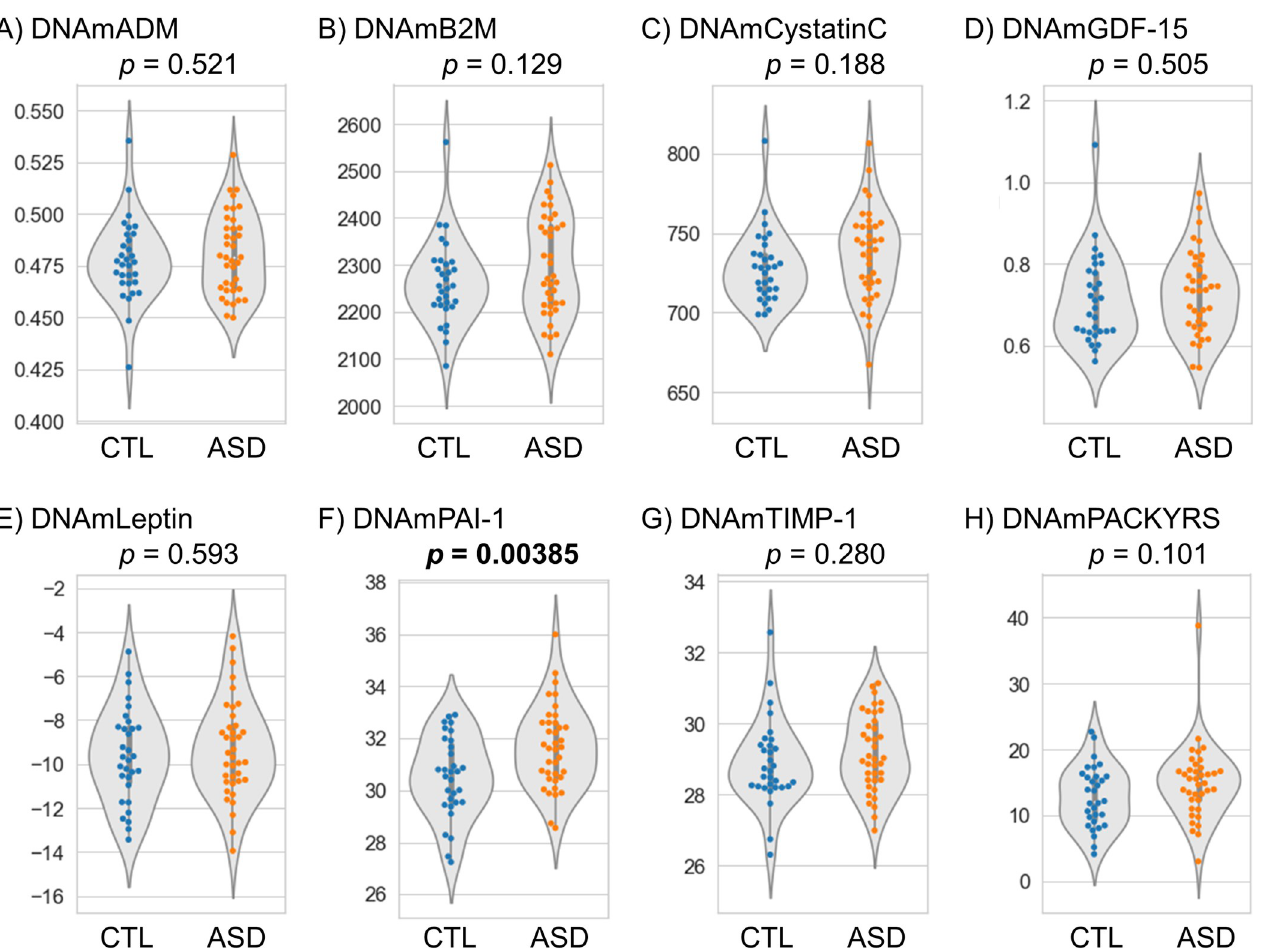
Fig 2. DNA methylation-based age-related plasma proteins and smoking status in the 1st cohort. ( A ) ADM, ( B ) B2M, ( C ) Cystatin C, ( D ) GDF-15, ( E ) Leptin, ( F ) PAI-1, ( G ) TIMP-1, and ( H ) PACKYRS. Student’s t-tests were performed for comparisons between the groups. ADM, adrenomedullin; ASD, autism spectrum disorder; B2M, beta-2-microglobulin; CTL, control; GDF-15, growth differentiation factor 15; PACKYRS, smoking pack-years; PAI-1, plasminogen activator inhibitor-1; TIMP-1, tissue inhibitor of metalloproteinases-1.